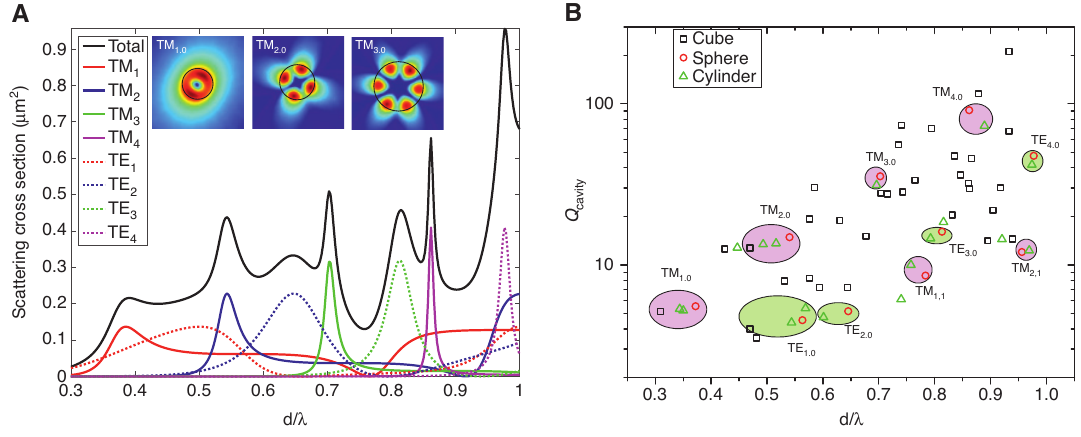
Figure 3: Resonant properties of halide perovskite cavities. (A) Analytically calculated dependence of scattering cross section with mode decomposition for a sphere with refractive index n = 2.5 on the ratio of the particle diameter (d) and incident light wavelength ( λ ). Inset: electric field distributions for the modes TM TM (d/ λ = 0.541), TM (d/ λ = 0.704). (B) Numerically calculated dependence of Q factors for eigenmodes in the particles of three different 2,0 3,0 shapes (spheres, cubes, and cylinders) on the ratio of diameter (or size for cubes) to wavelength. For cylinders, we consider height is equal to 200